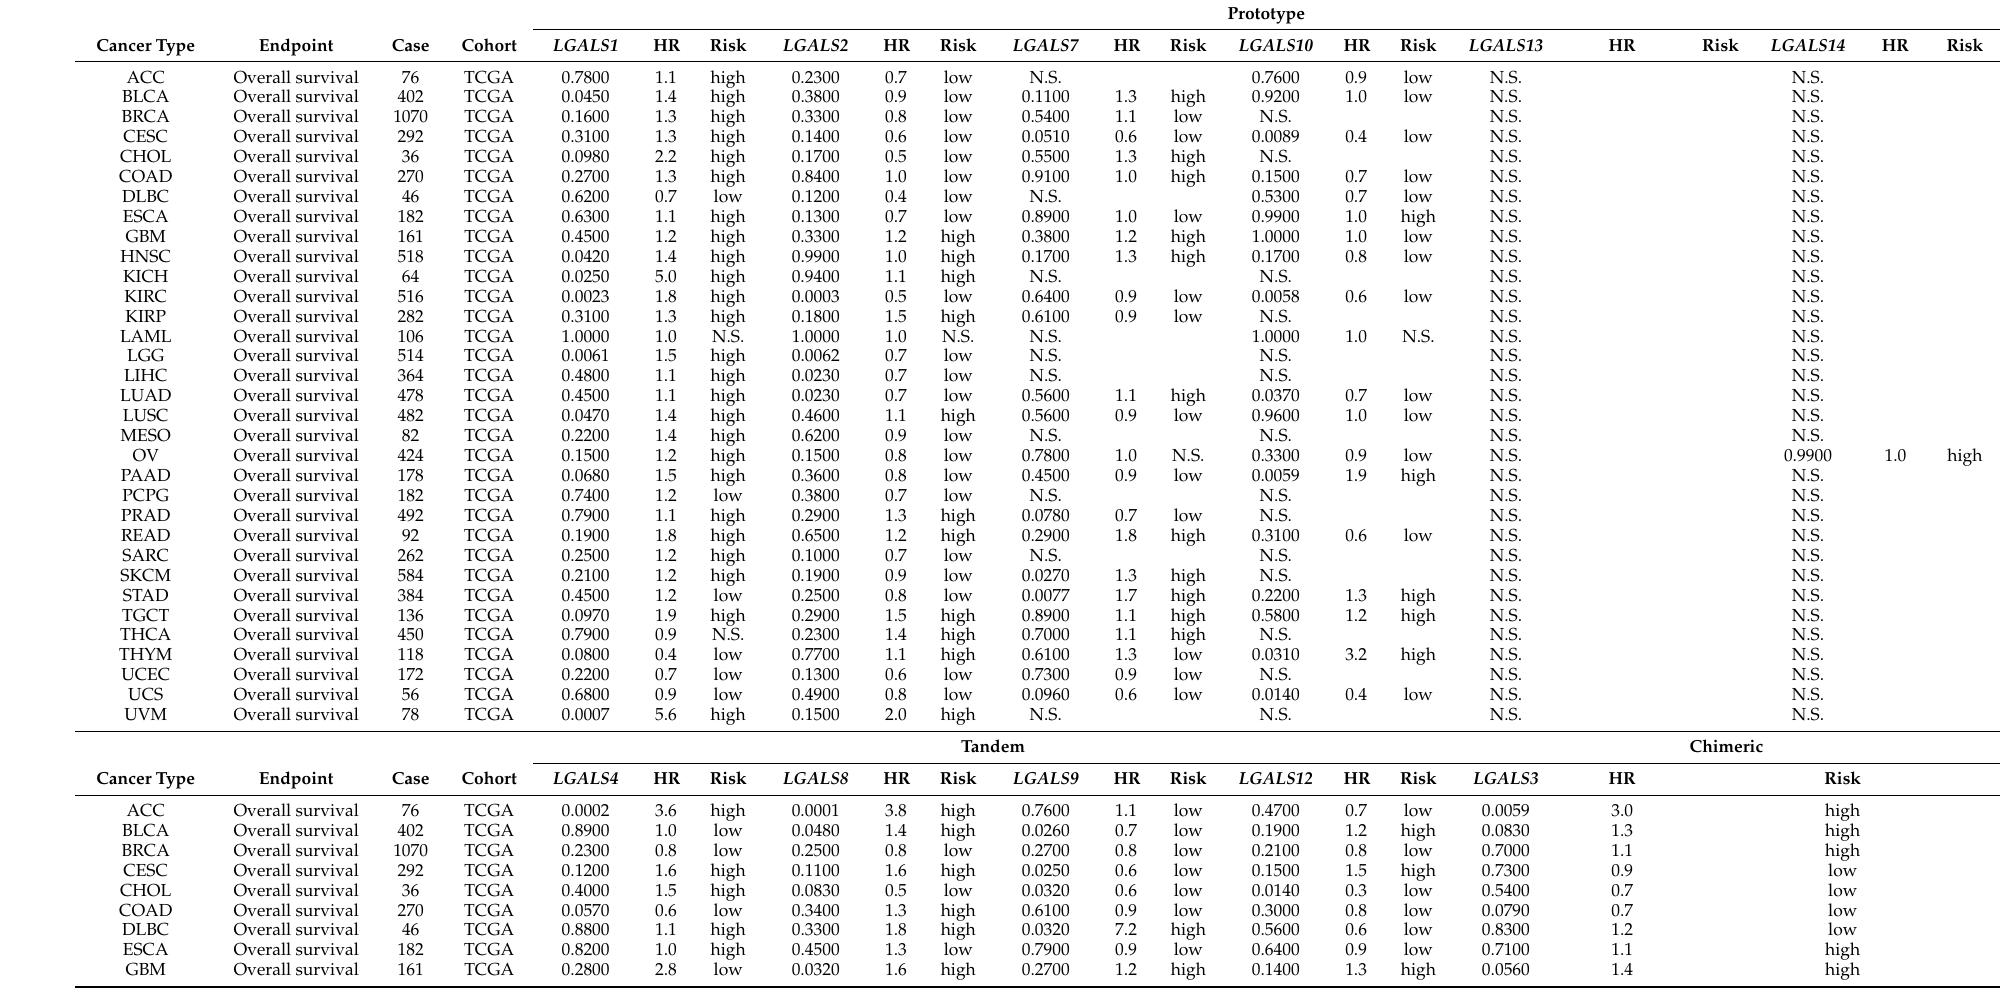
Table 2. The prognostic role of galectin family members of pan-cancer in TCGA cohorts.